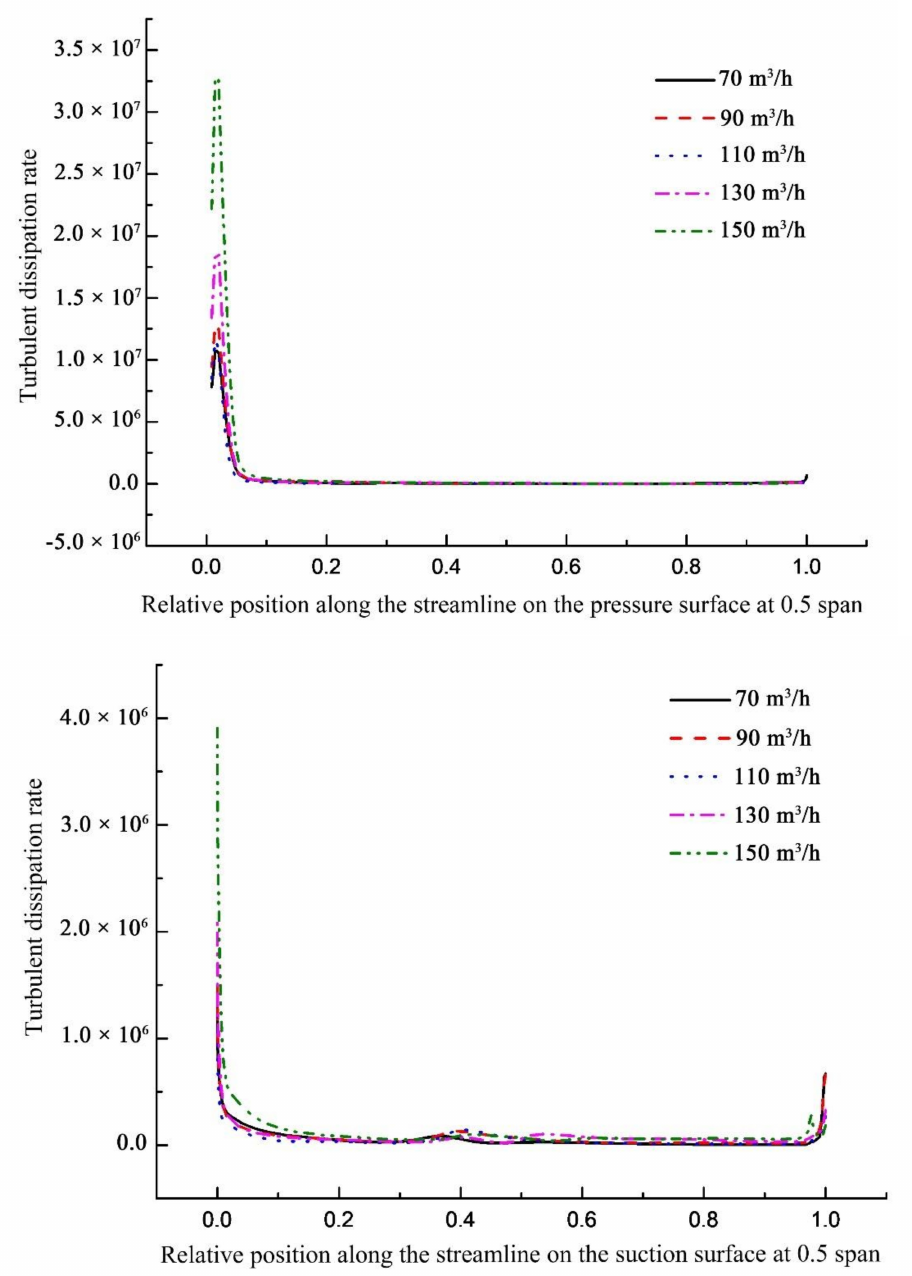
Figure 12. The turbulence dissipation rate distribution pattern of the pressure surface and the suction surface of the first-stage impeller blade at the 0.5 span under different flow